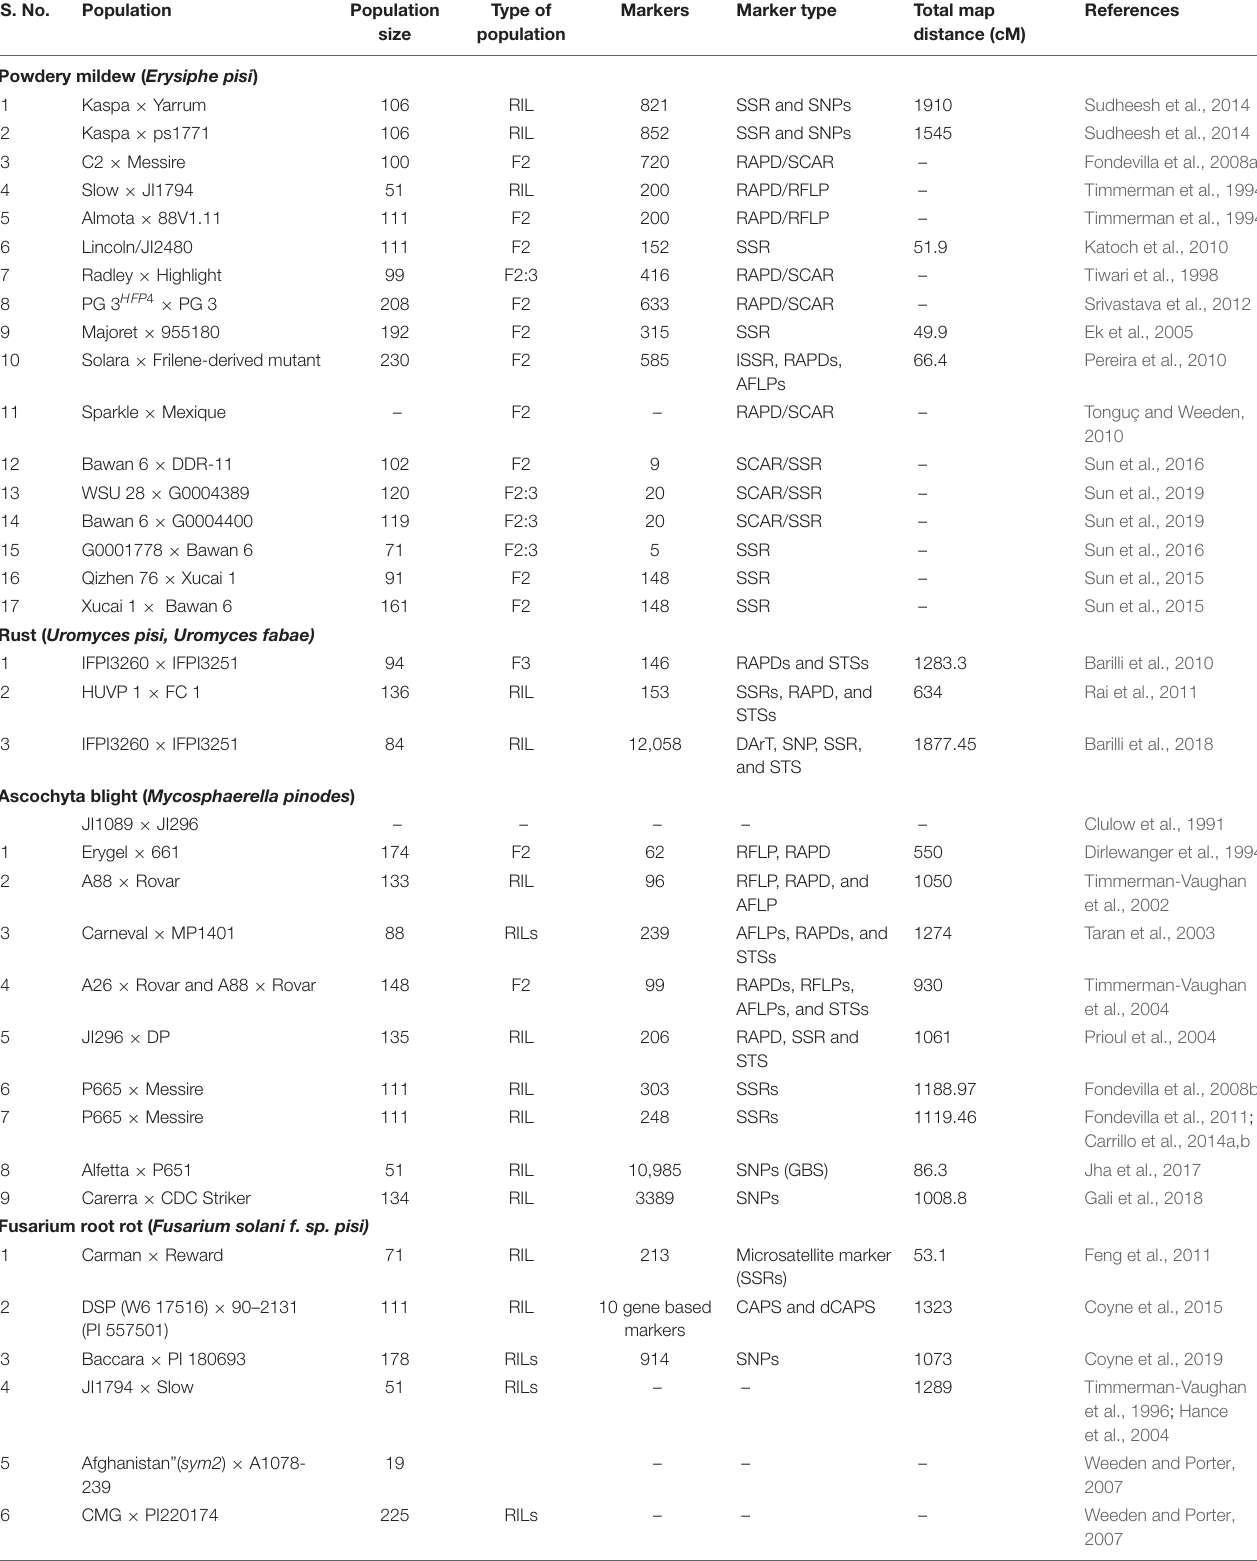
TABLE 2 | Available genetic maps for different biotic stresses in field pea ( Pisum sativum L.). S.